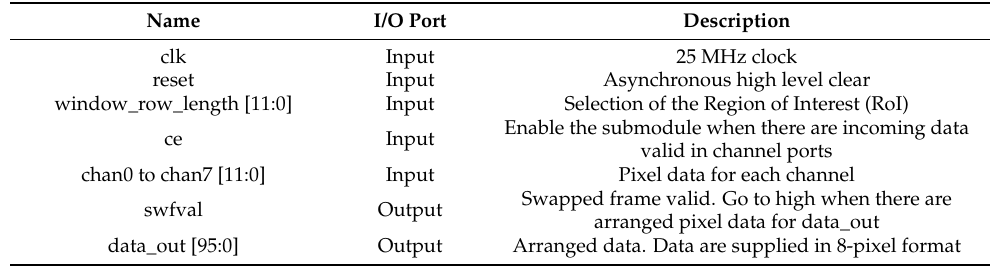
Figure 8. Block diagram of the implemented swapping.vhd module.